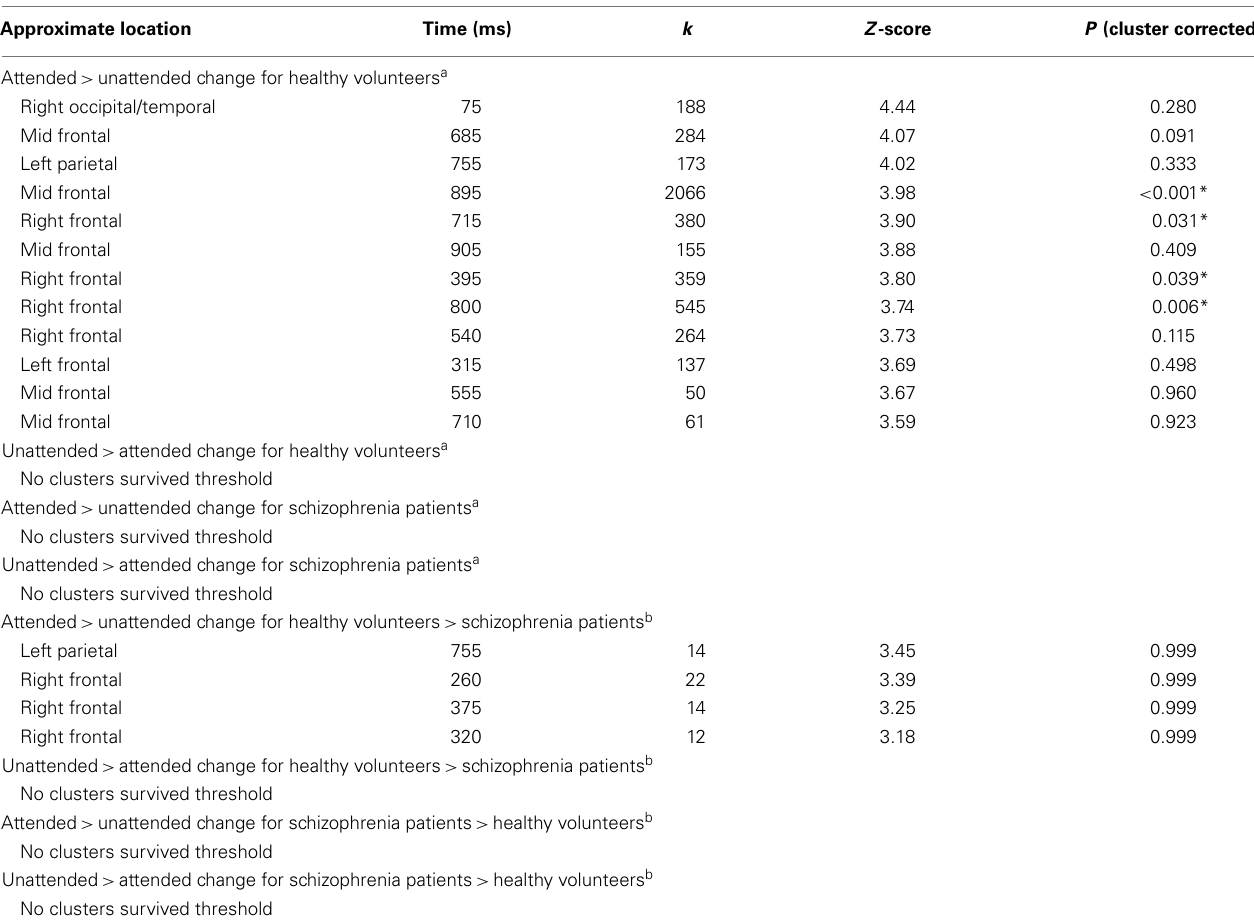
Table 3 | Results for contrast images for MEG sensor-space